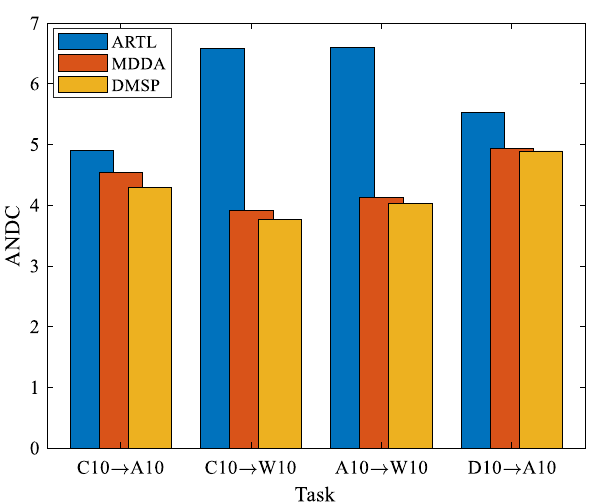
Fig. 5 ANDC values produced by DMSP, ARTL and